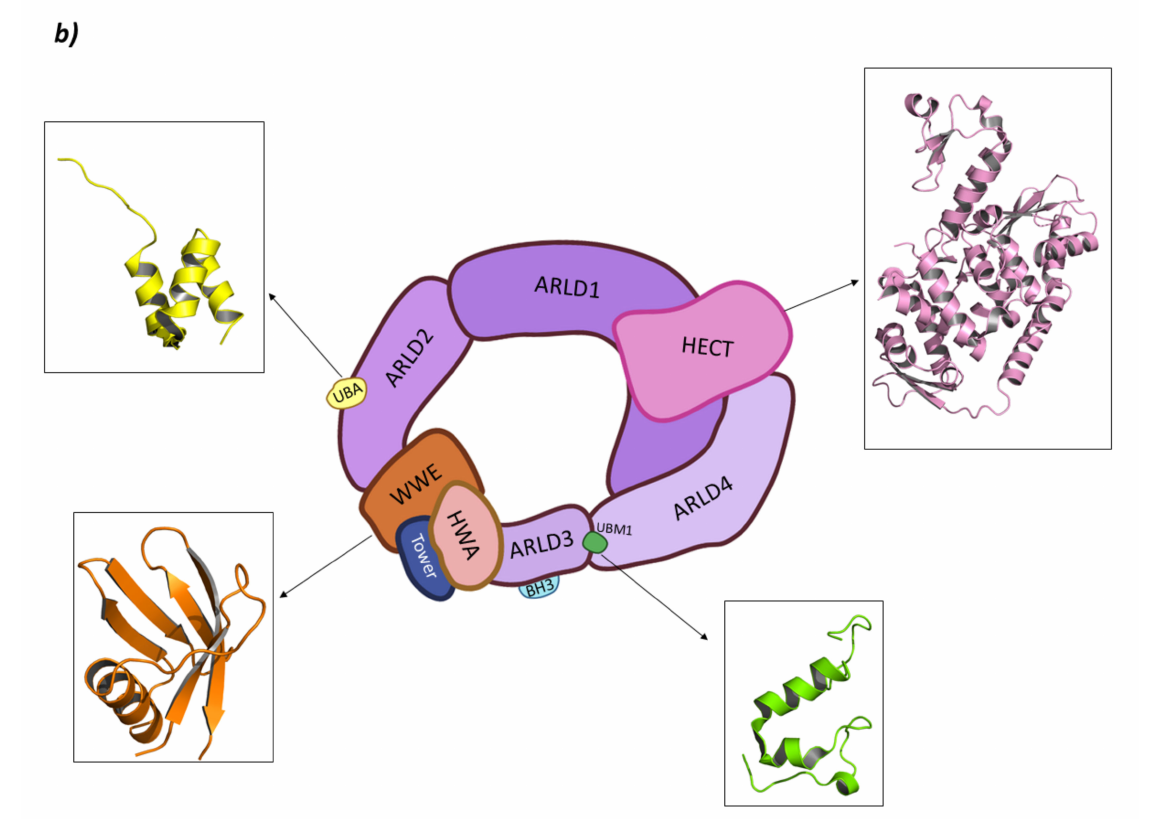
Figure 11. HECT E3 ligases. ( a ) Smurf2. I is the schematic representation of the assembly of the Smurf2 E3 ligase: ubiquitin (Ub) in purple, E2 ligase (E2) in dark blue, HECT domain (HECT) in pink, WW3 domain in light blue, WW2 domain in orange, WW1 in yellow, C2 domain in green, and substrate protein in grey. Protein assembly II is the 3D representation of the C2 domain as found in PDB code 2JQZ. Protein assembly III is the 3D representation of the WW2 and WW3 domains in complex with a fragment of the substrate protein Smad7 as found in PDB code 2KXQ. Protein assembly IV is the 3D representation of the HECT domain as found in PDB code 1ZVD. ( b ) HUWE1. Schematic representation of the assembly of the Smurf2 E3 ligase adapted from Hunkeler M. et al. [162]: HECT domain (HECT) in pink, armadillo repeated as domain 1–4 (ARLD1–4) in shades of lilac, ubiquitin associated domain (UBA) in yellow, tryptophan and glutamic acid-rich domain (WWE) in orange, HUWE1 WWE module associated domain (HWA) in salmon pink, tower domain in dark blue, Bcl-2 homology region 3 (BH3) in light blue, and ubiquitin binding motif 1 (UBM1) in green. The 3D representation of the individually crystalized fragments of this assembly are represented next to their position in the scheme (UBA (PDB code 2EKK) yellow, HECT (PDB code 3H1D) pink, WWE (PDB code 6MIW) orange, and UBM1 (PDB code 2MUL)